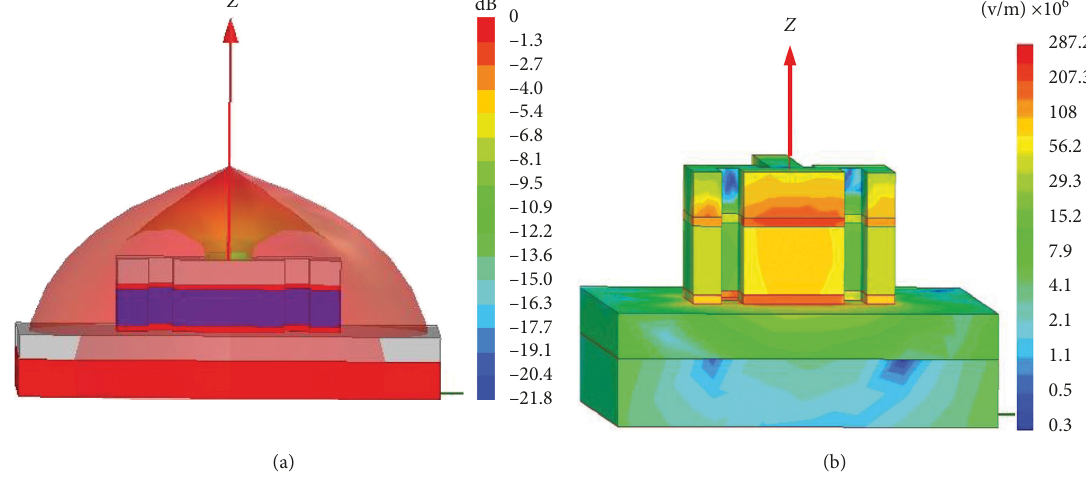
Figure 6: HMIM nanopatch antenna results for 160.17 THz frequencies. (a) Far-field radiation. (b) Electric field distribution.